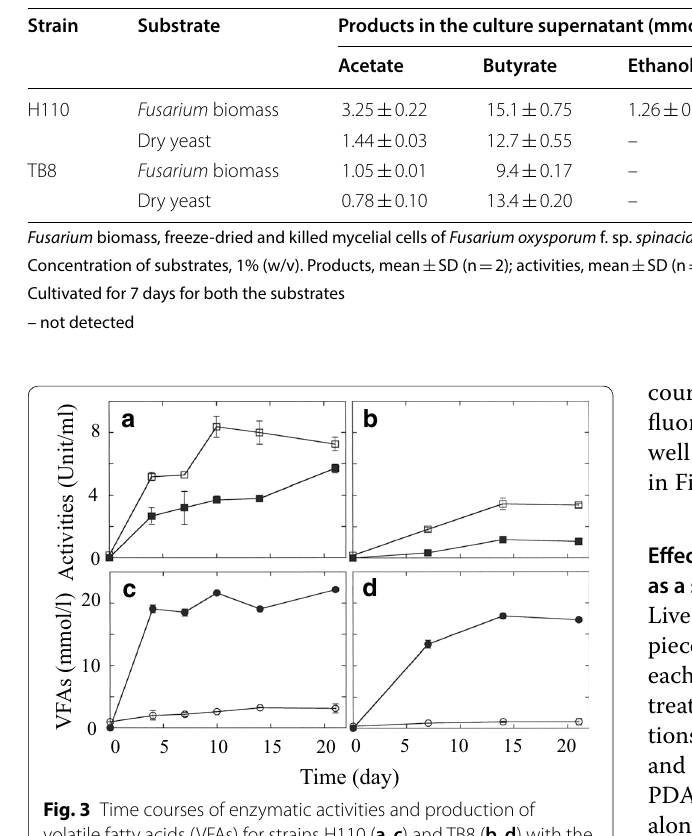
Table 3 Products and enzymatic activities in the culture supernatants of strains H110 and TB8 grown with cell biomass of the Fusarium pathogen and yeast in the PY broth